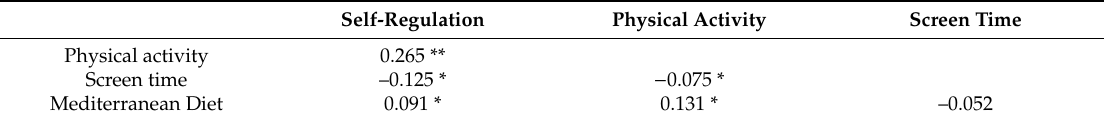
Table 2. Partial correlations between self-regulation with physical activity, screen time, and Mediterranean